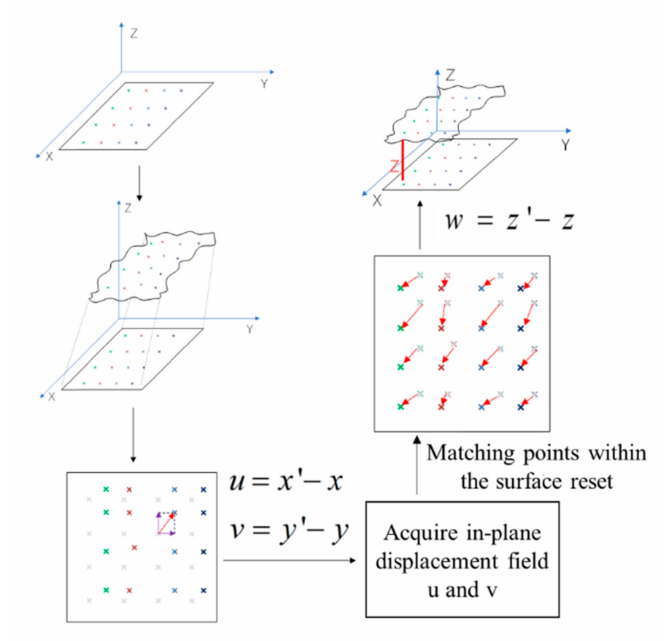
Figure 2. The measurement principle of the three dimensional (3D) deformation measurement